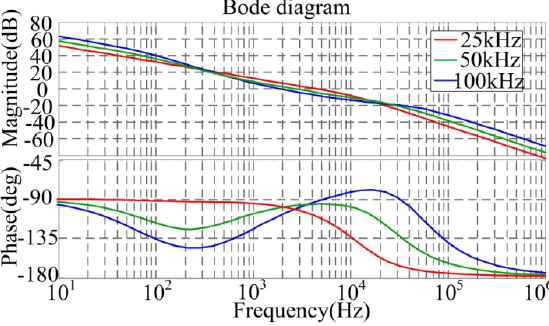
Figure 21. Frequency response of T ( s ) under different switching frequencies.